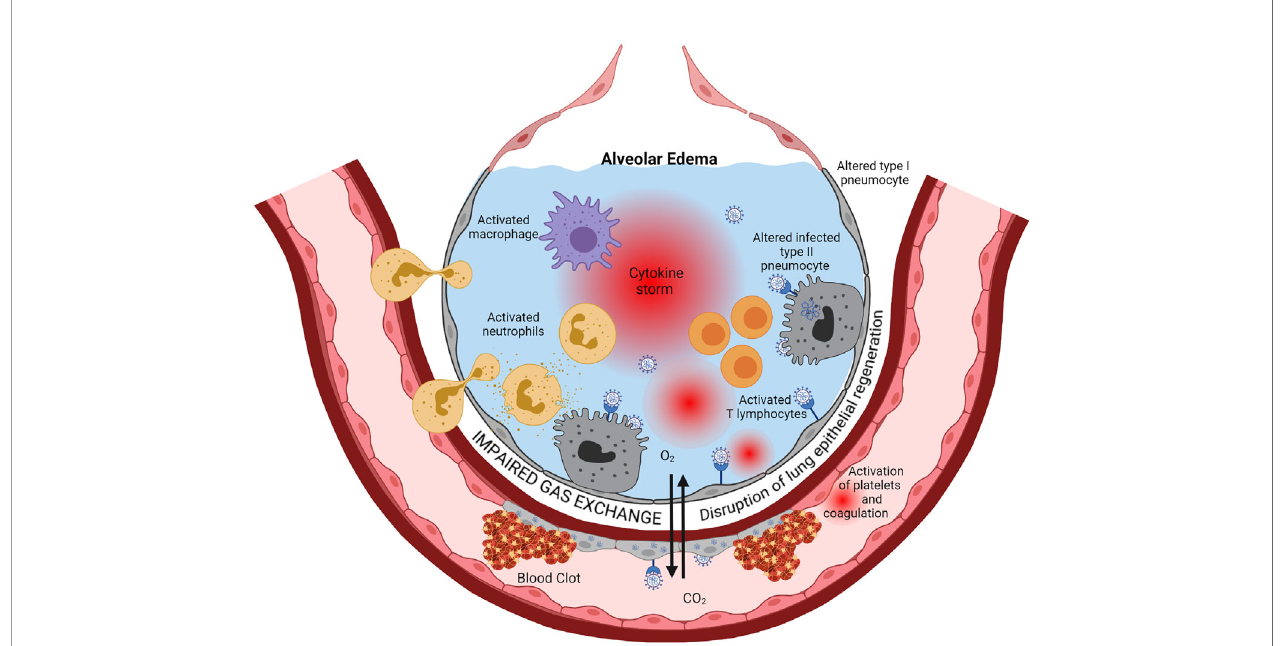
FIGURE 1 | Immunopathology of ARDS. Cytopathic SARS-CoV-2 infection of pulmonary epithelial cells and endothelial cells is the starting point of a series of cascading pro-in fl ammatory events leading to ARDS eventually. Viral replication, via activation of the innate immune response components such as TLR, triggers the production of interferons, in fl ammatory cytokines, and chemokines. This in fl ammation induces in fi ltration into the alveoli and activation of neutrophils, macrophages, and lymphocytes. Activated immune cells produce large amounts of pro-in fl ammatory cytokines such as IL-6, IL-1 b , TNF- a , and IL-8 that exacerbate local cell recruitment and activation, leading to a “ cytokine storm ” through this ampli fi cation loop. The increase of capillary permeability causes pulmonary edema. Thrombosis occurs via several mechanisms, including injury of endothelial cells by the virus and subsequent activation of the coagulation cascade, activation of neutrophils that secrete procoagulant factors, and activation of complement that leads to activation of platelet and coagulation. Regeneration of the lung epithelia is impaired. This cascade of events ends in a severe impairment of Gas exchanges between alveoli and lung capillaries, causing hypoxemia. Created with